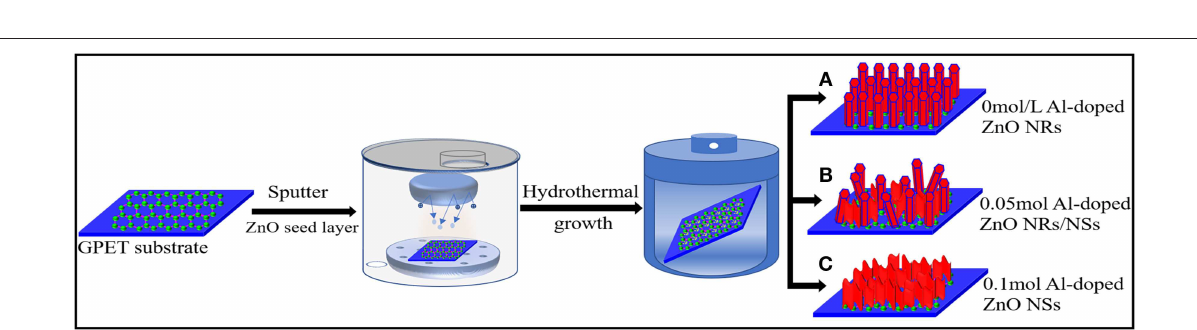
electrochemical property (Zhang et al., 2015). As can be seen from the XRD image ( Figure 1D ), except for the characteristic peaks belonging to graphene and GPET substrate appearing at 26 ◦ and 54 ◦ , the other peaks are the diffraction peaks of ZnO, which are basically in agreement with the standard PDF card (JCPDS 89-1397) of ZnO. Moreover, the (002) diffraction peak strength is higher than (100) and (101), which indicates that AZO grow preferentially perpendicular to the substrate along the c-axis. The doping of Al generates stress during crystallization, and the crystal structure of ZnO changes accordingly. Further, the intensity of the diffraction peaks of (002) may become weak due to the incorporation of Al